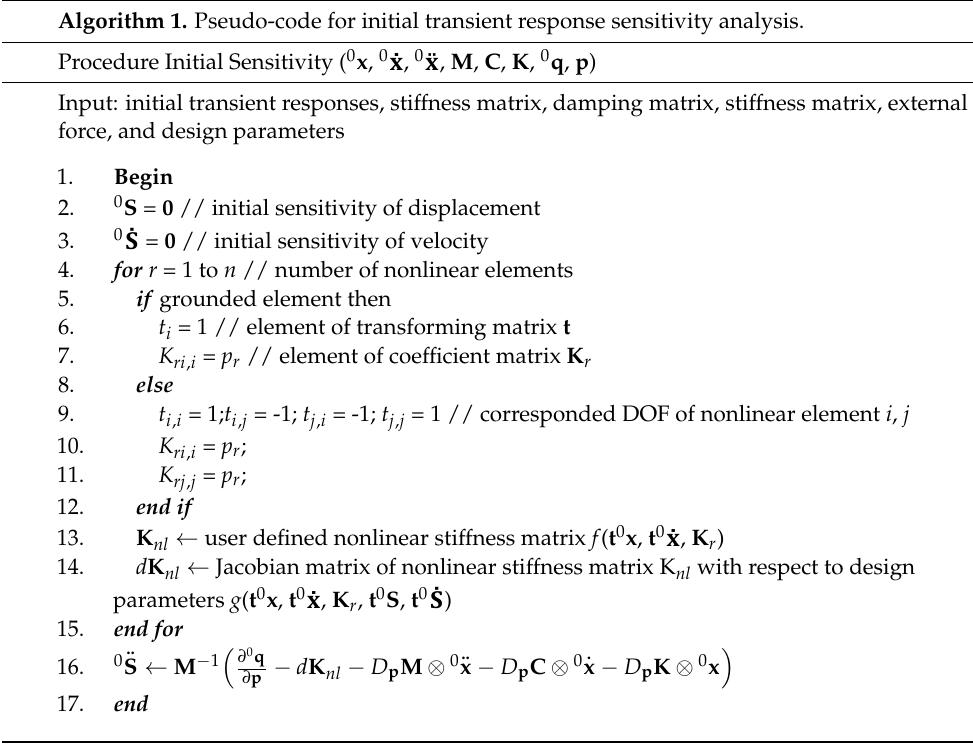
Algorithm 1. Pseudo-code for initial transient response sensitivity analysis. Procedure Initial Sensitivity ( 0 x , 0